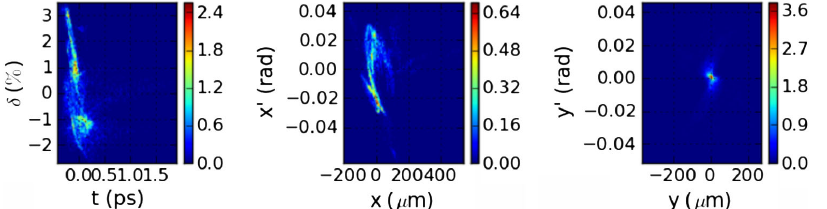
12. The histograms of a bunch ’ s longitudinal phase space (the left column), horizontal phase space (the middle column), and vertical phase space (the right column) at the final point of the linac compressor for case 6 in Table II. These plots are plotted for 100% particles at the final point of the linac bunch compressor. The color bar shows the particle density. The simulation code is IMPACT - T with both space charge effects and CSR effects being turned